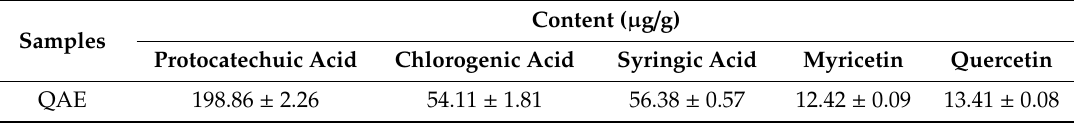
Table 1. Contents of protocatechuic acid, chlorogenic acid, syringic acid, myricetin, and quercetin compounds by HPLC analysis in the presence of Quamoclit angulata extract (QAE). Samples